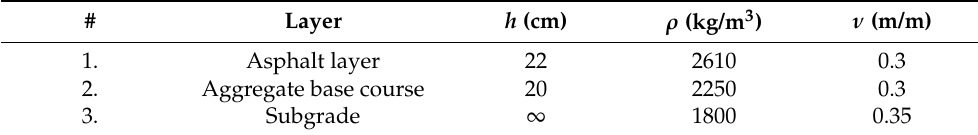
Table 1. Geometrical and material parameters of road